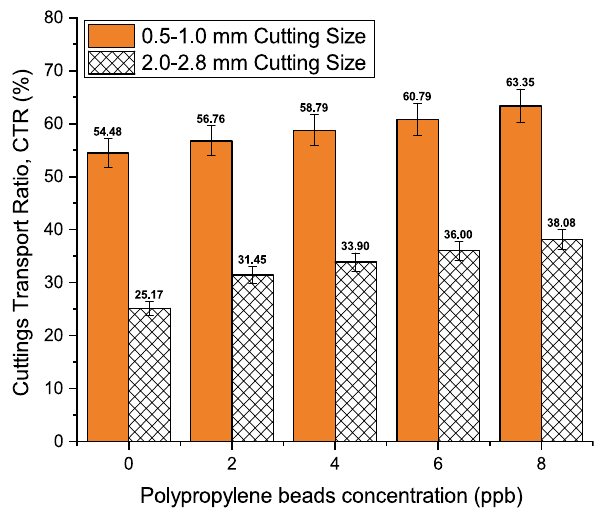
Fig. 7 CTR versus polypropylene bead concentration for both cut- tings sizes without pipe rotation (0 RPM)